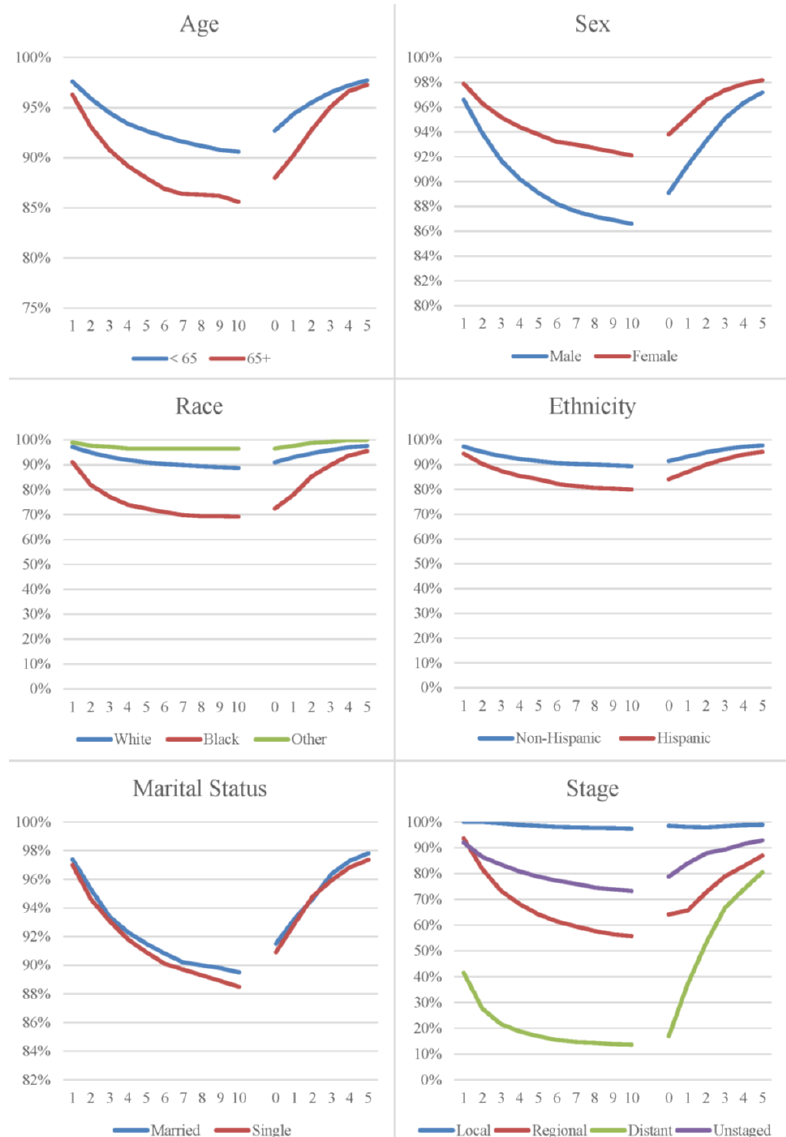
Figure 1. Relative ( left ) and conditional relative ( right ) survival curves for melanoma.